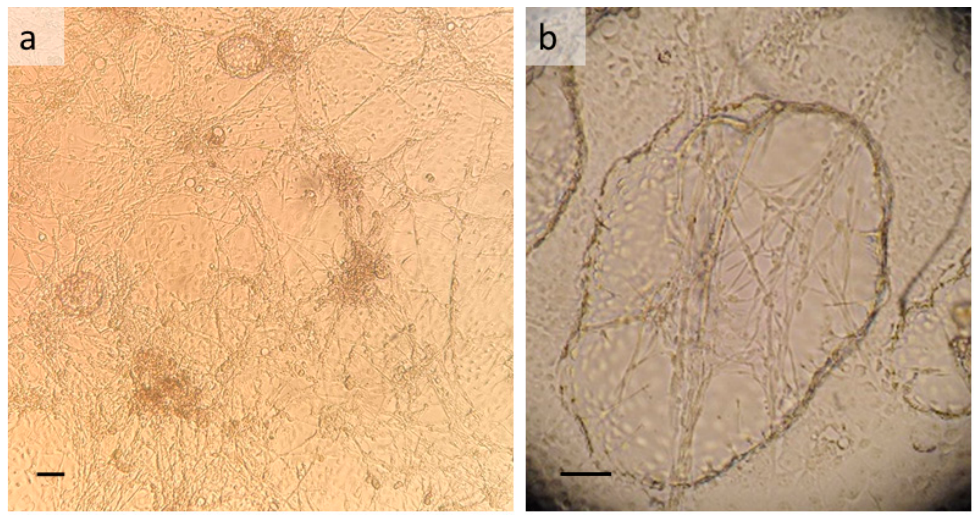
Figure 1. Triatoma infestans embryo-derived cell line TIE/LULS54. ( a ) General view of monolayer at passage 6; ( b ) blister-like multicellular dome formed above the cell monolayer in a ten-week-old passage 3 culture. Live, inverted microscope; scale bars 100 µm.